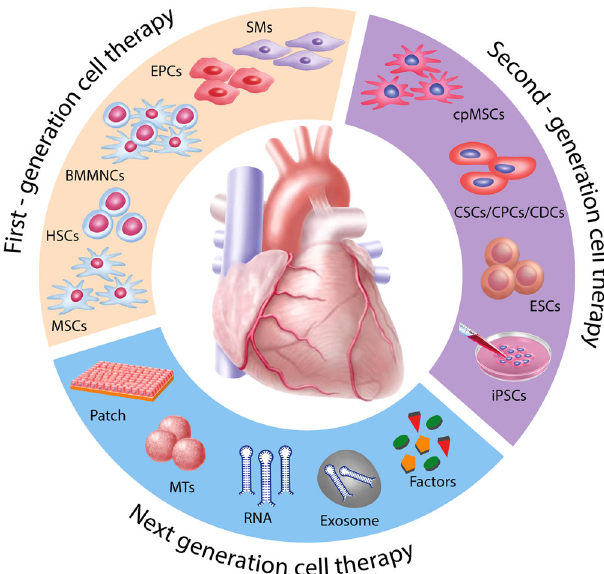
Fig. 1 Evolution of translational cardiac regenerative therapies. First-generation cell types such as SMs, BMMNCs, HSCs, EPCs, and MSCs demonstrated feasibility and safety with, however, hetero- geneous outcomes and limited ef fi cacy in the clinical setting. In order to better match the target organ, second-generation cell therapies propose the use of cpMSCs, CSCs/CPCs, and CDCs, and pluripotent stem cells such as ESCs and iPSCs. Next-generation therapies for cardiac repair are directed toward cell enhancement (e.g., biomaterials, 3D cell constructs, cytokines, miRNAs) and cell- free concepts (e.g., growth factors, non-coding RNAs, extracellular vesicles, and direct